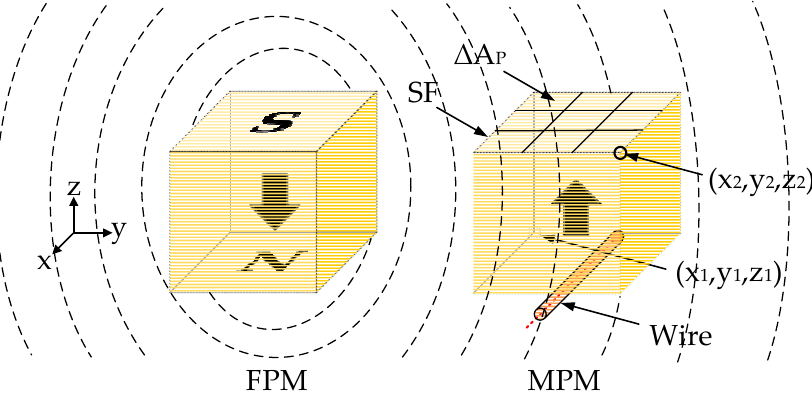
Figure 4. Magnets and coordinate system illustrated for magnetic force calculation.